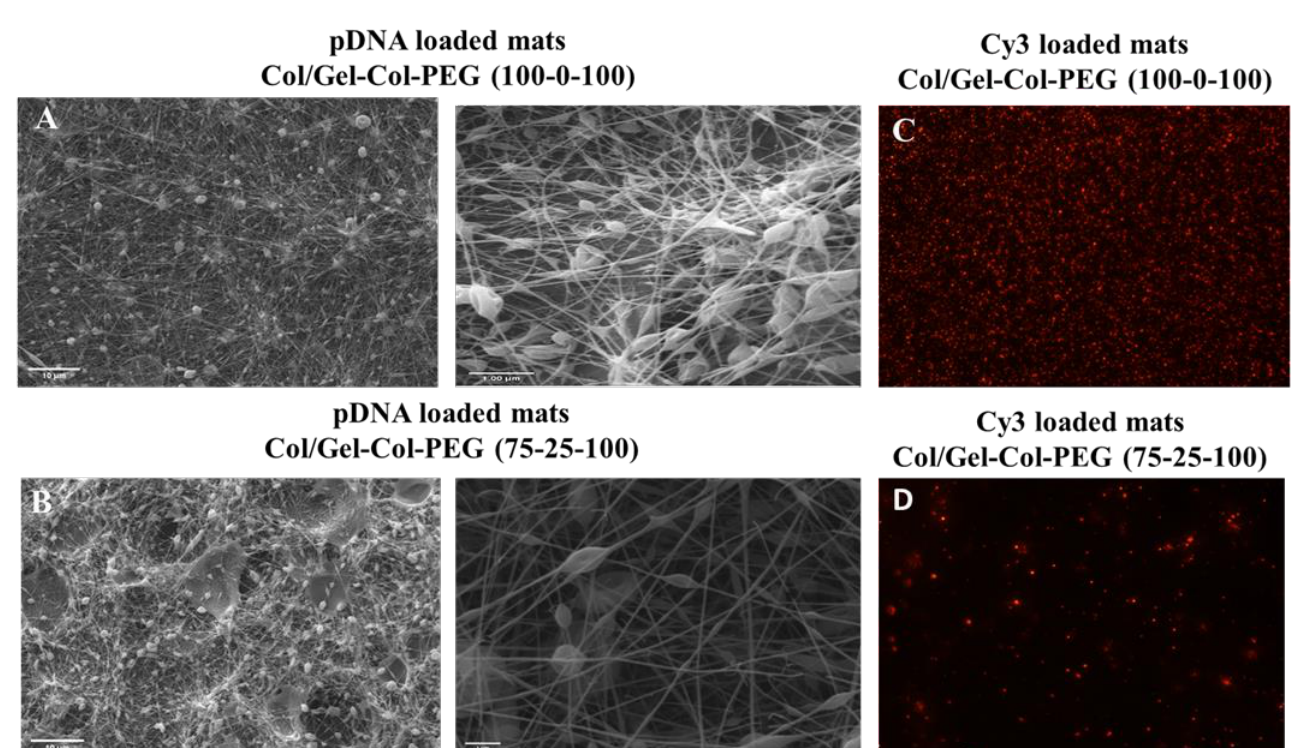
Figure 5. The SEM images ( A , B ) of multilayered Collagen/Gelatin-Collagen-PEG ( A ): (100-0-100) and ( B ): (75-25-100)) mats with complexes (scale bars 10 and 1 μm). Fluorescence microscopy images of multilayered Collagen/Gelatin-Collagen-PEG mats ( C ): 100-0-100 and ( D ): 75-25-100) mats with Cy3-labeled pDNA complexes.